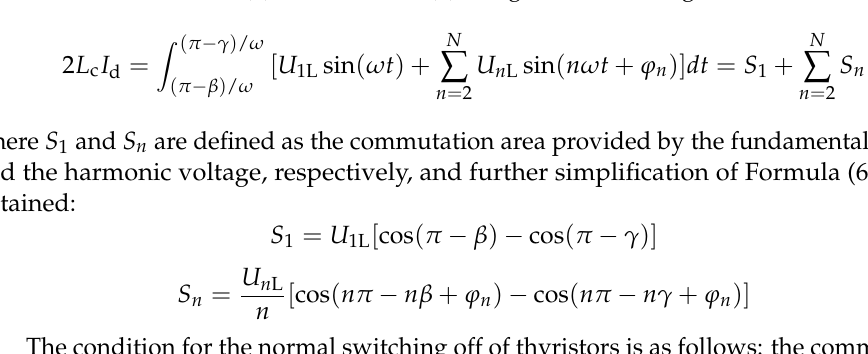
Figure 5. Response waveform of inverter side after three-phase short-circuit grounding fault.